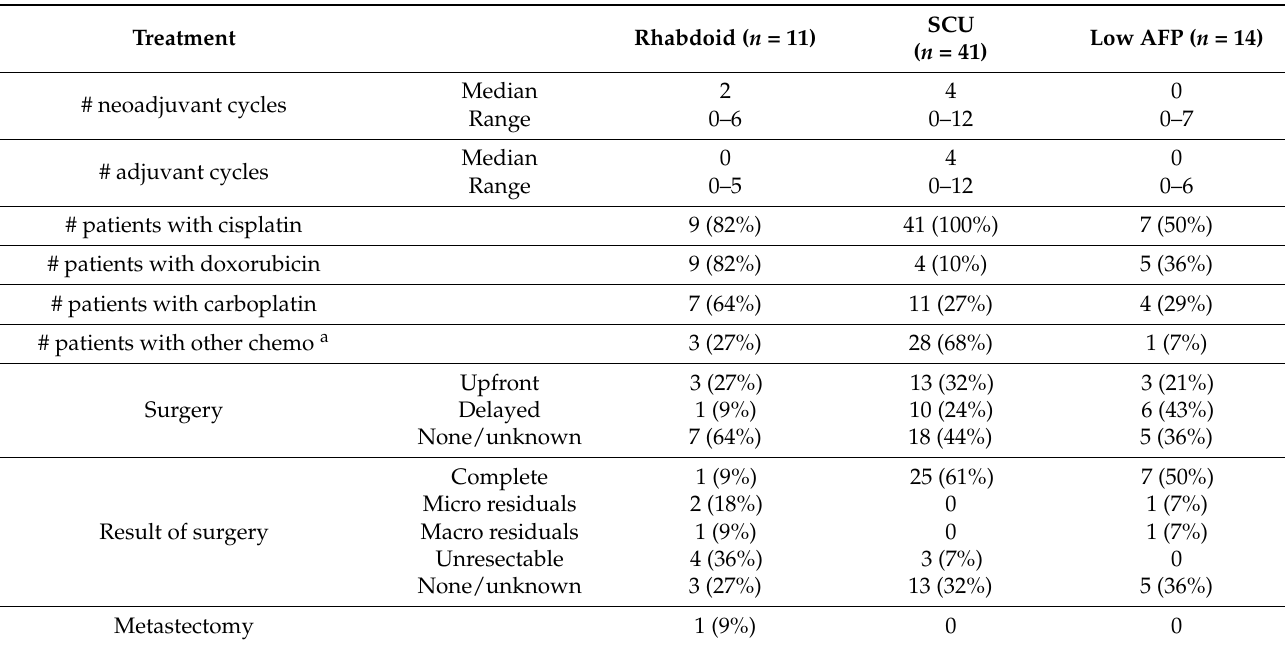
Table 2. Treatment details by